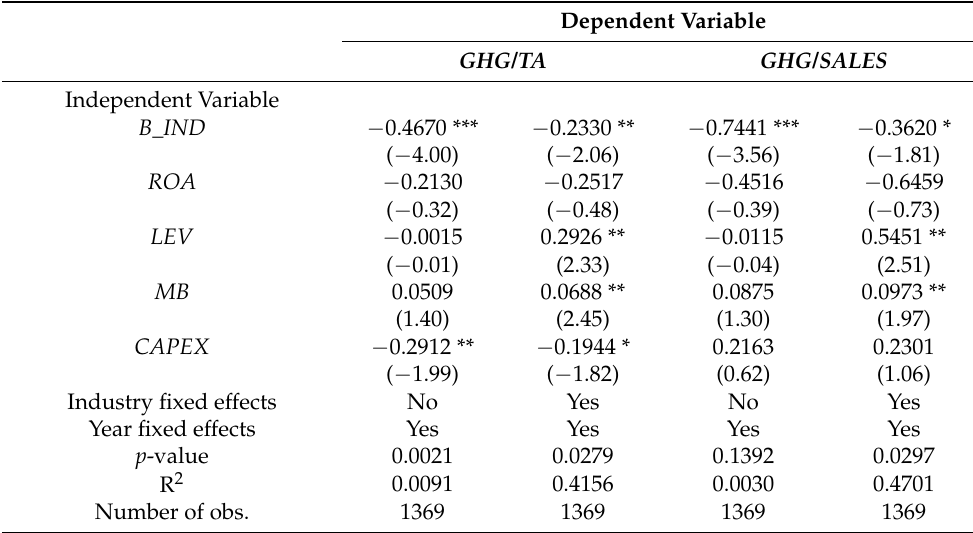
Table 3. Board Independence and Carbon